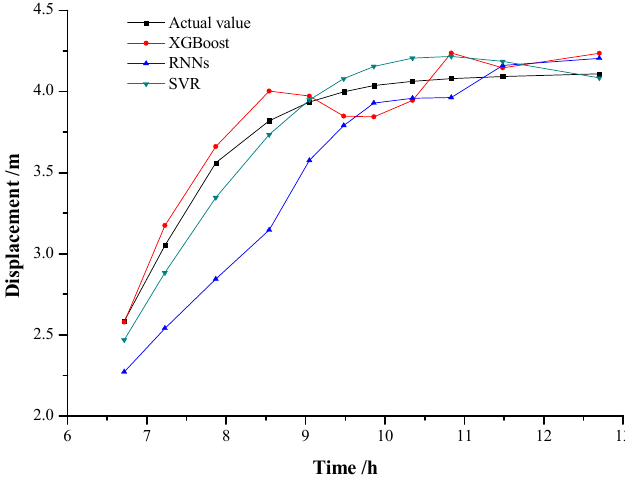
Figure 10. Variation of displacement predicted values of D9 with time.